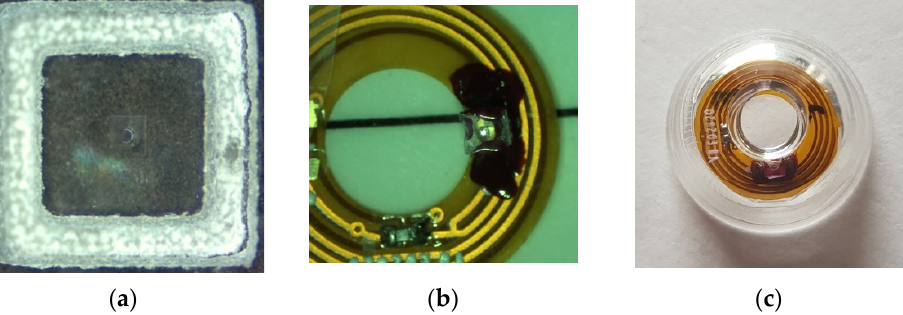
Figure 13. ( a ) DOE of dimensions 225 × 225 µm 2 on a glass square of 1.2 × 1.2 mm 2 , ( b ) mounted on the VCSEL, ( c ) encapsulated in the SCL [20].